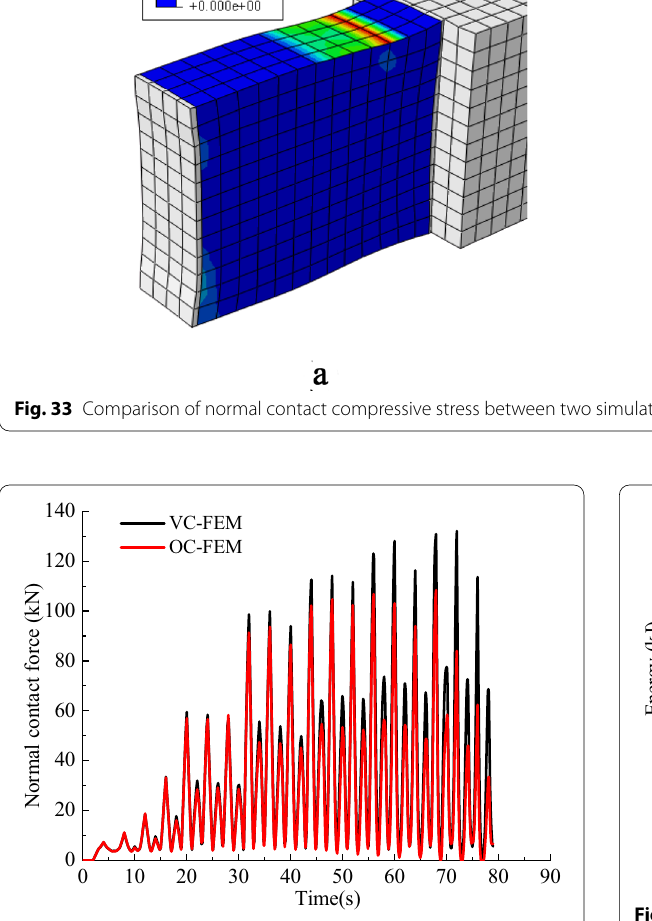
Fig. 34 Comparison of normal contact force between two simulation methods